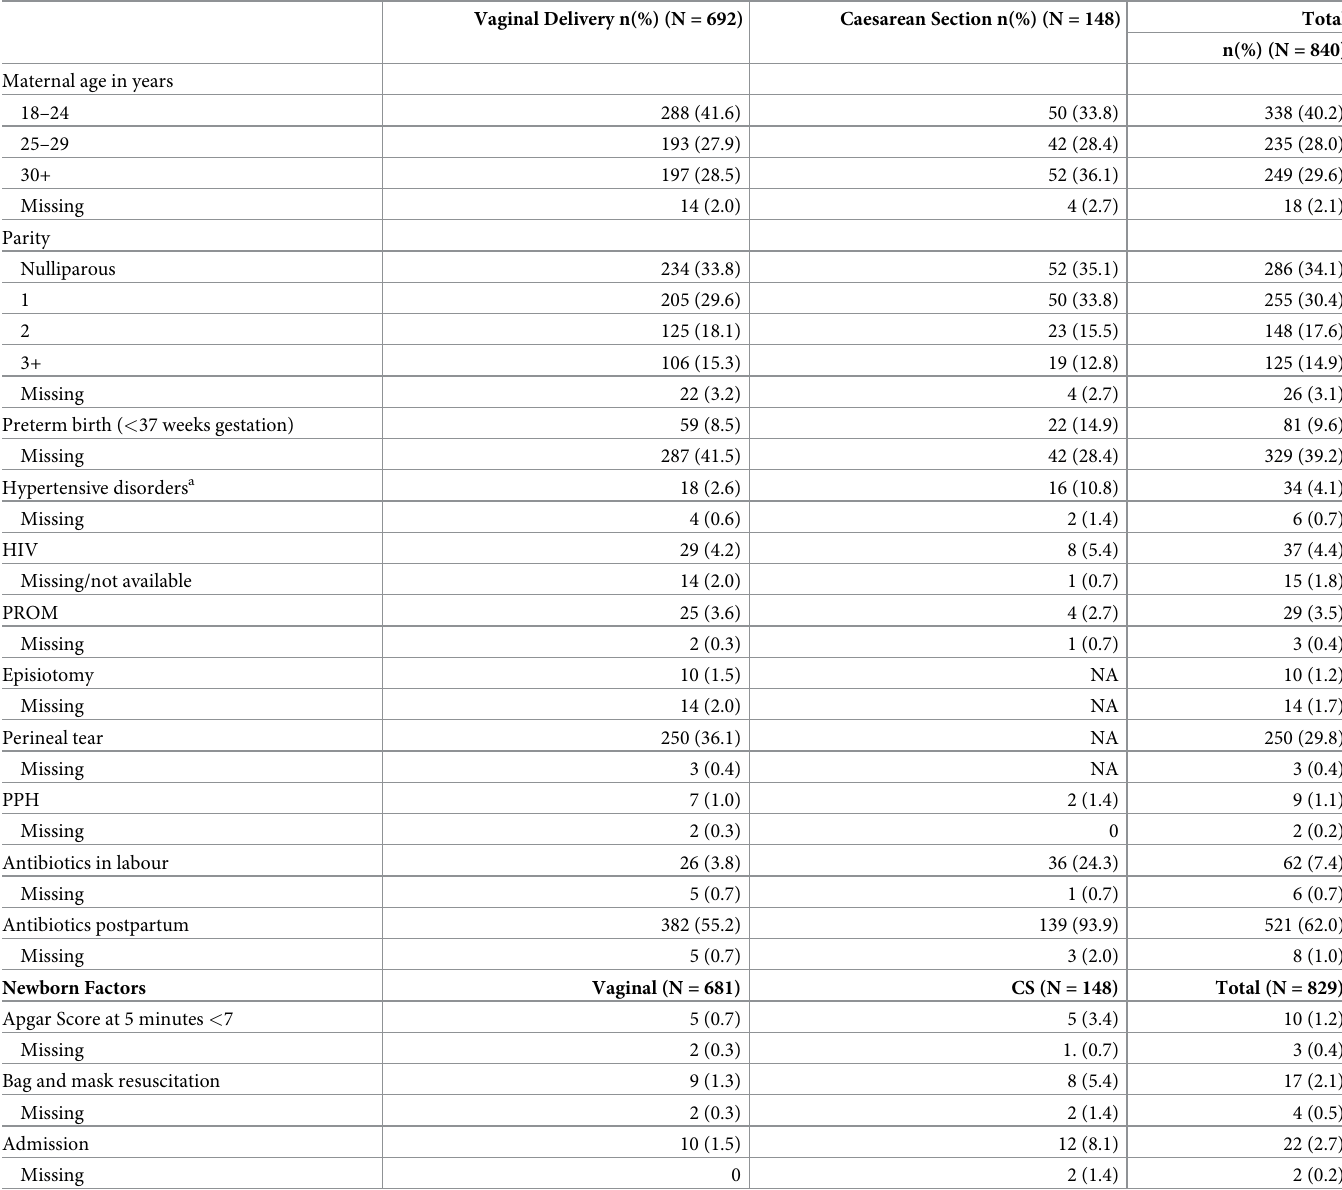
Table 2. Demographic, pregnancy and newborn factors by mode of delivery for 840 women and 829 liveborn babies with maternal hospital